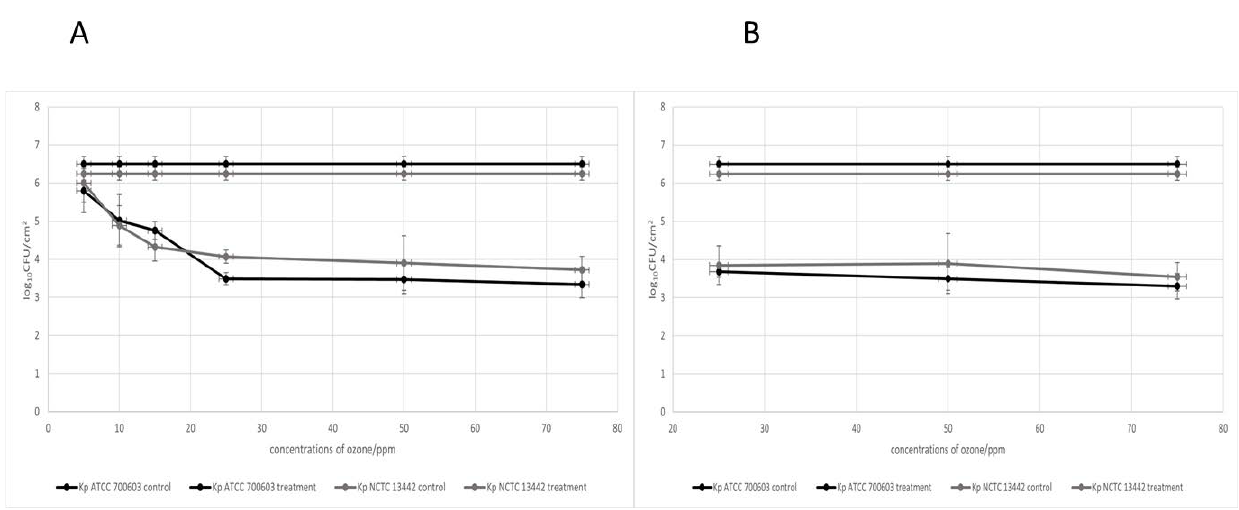
Figure 2. Antimicrobial effect on 24 h biofilm of K. pneumoniae NCTC 13442 (Kp NCTC 13442) and K. pneumoniae ATCC 700603 (Kp ATCC 700603) of different ozone concentrations (ppm) for 1 h exposure time ( A ) and 2 h exposure time ( B ). Results are presented with average ( · ) and standard